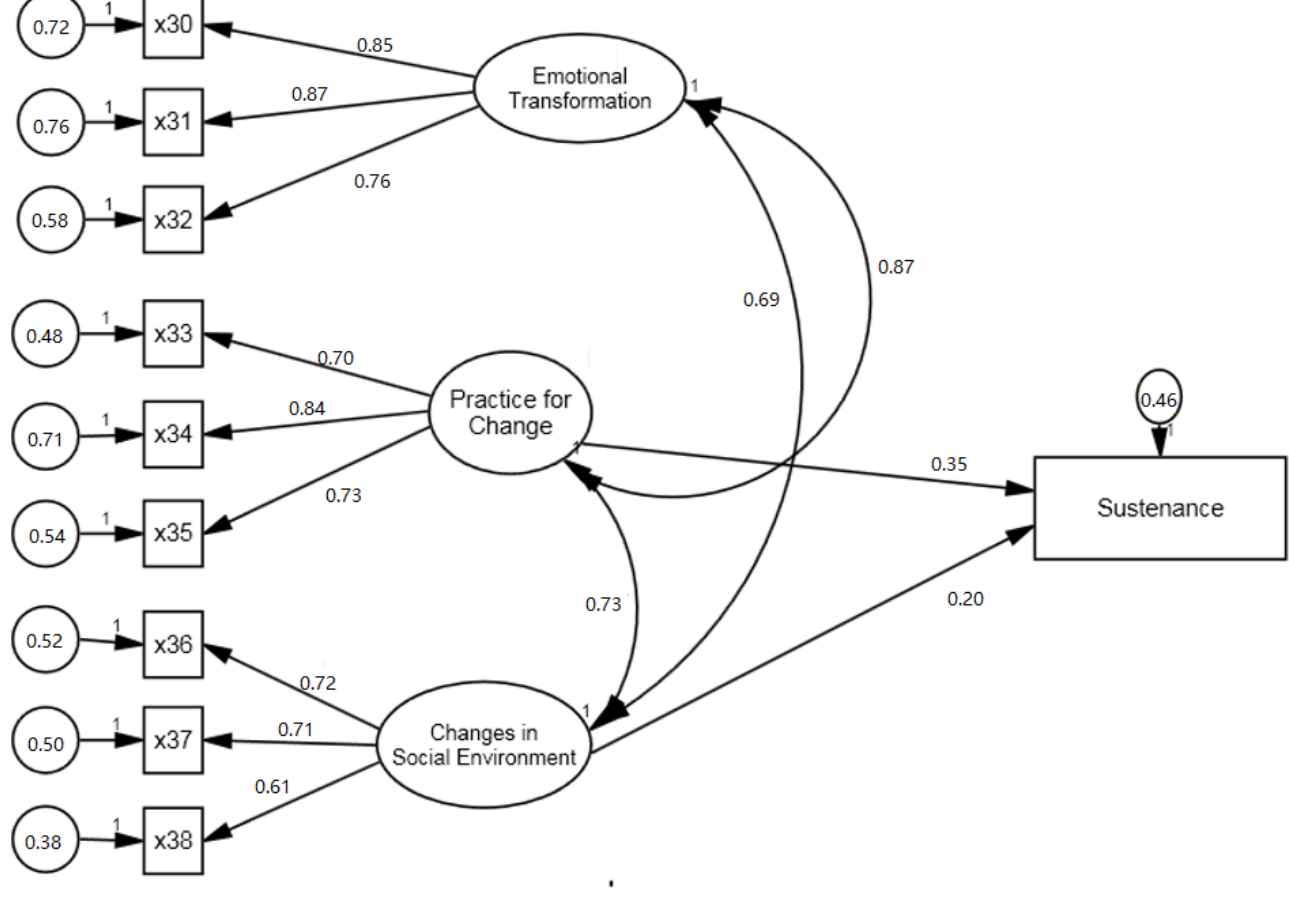
Figure 5. Structural model for sustaining flossing.